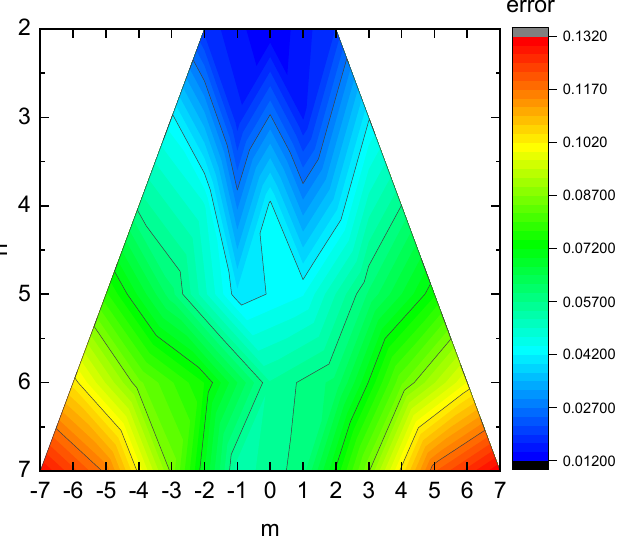
Figure 9. Zernike coefficient error map with radial variables n and angular variables m.